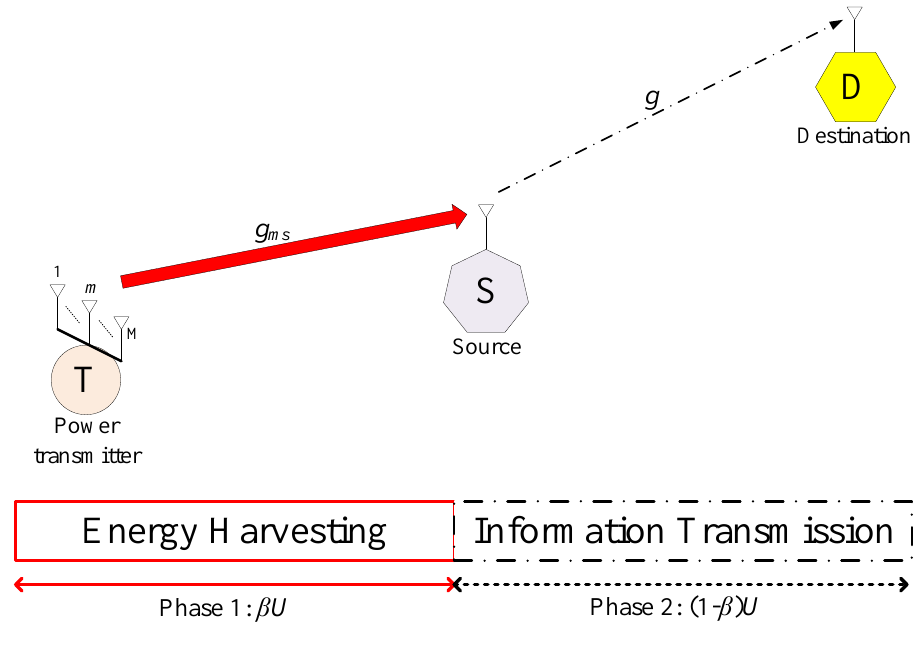
Figure 1. Wireless communications with energy